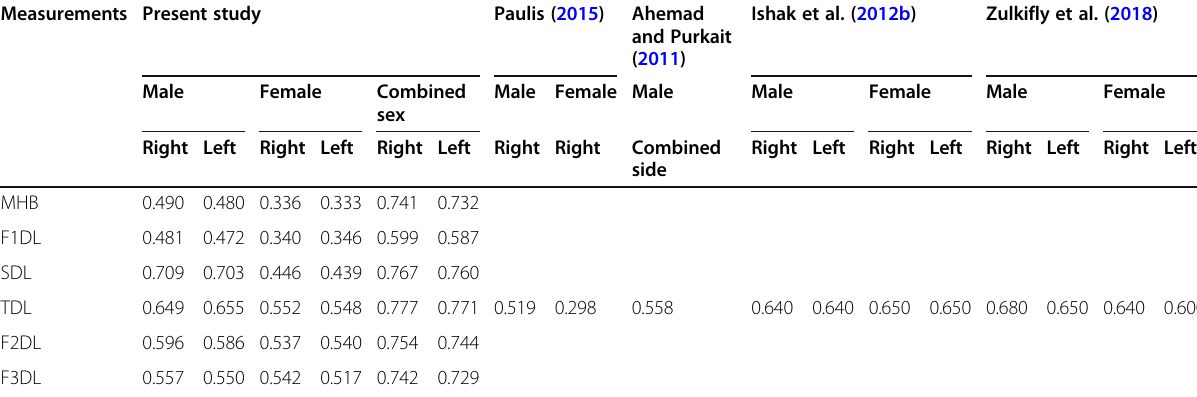
breadth; handprint length; handprint thumb, index, mid- dle, ring, little finger length; phalangeal length of thumb distal, thumb proximal, index distal, index middle, index proximal, middle distal, middle medial, middle proximal, ring distal, ring middle, ring proximal, little distal, little middle; and little proximal dimensions for developing regression equations. The SSE values were ranged from ± 54.2 to ± 75.5 mm in males, and ± 46.7 to ± 59.9 mm tions were derived using handprint breadth, maximum handprint breadth, 1st digit length, 2nd digit length, 3rd digit length, 4th digit length, and 5th digit length. In comparison, our study revealed lower values of SSE (±